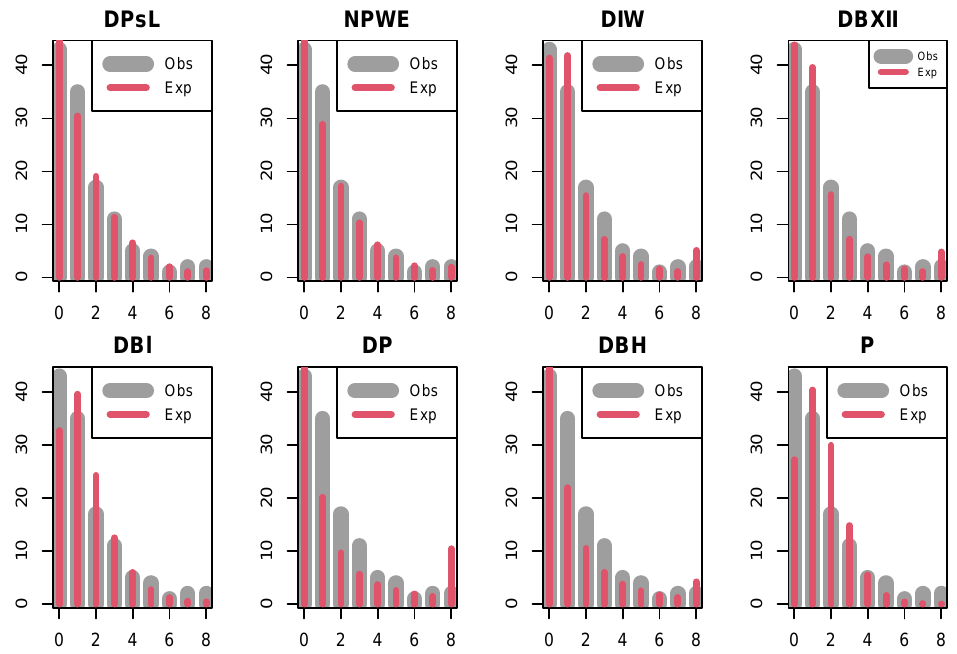
Figure 5. The estimated pmfs of the fitted distributions for the number of borers dataset. Table 12. Values of some descriptive statistics of the DPsL distribution for the number of borers dataset. Mean Variance DI Skewness